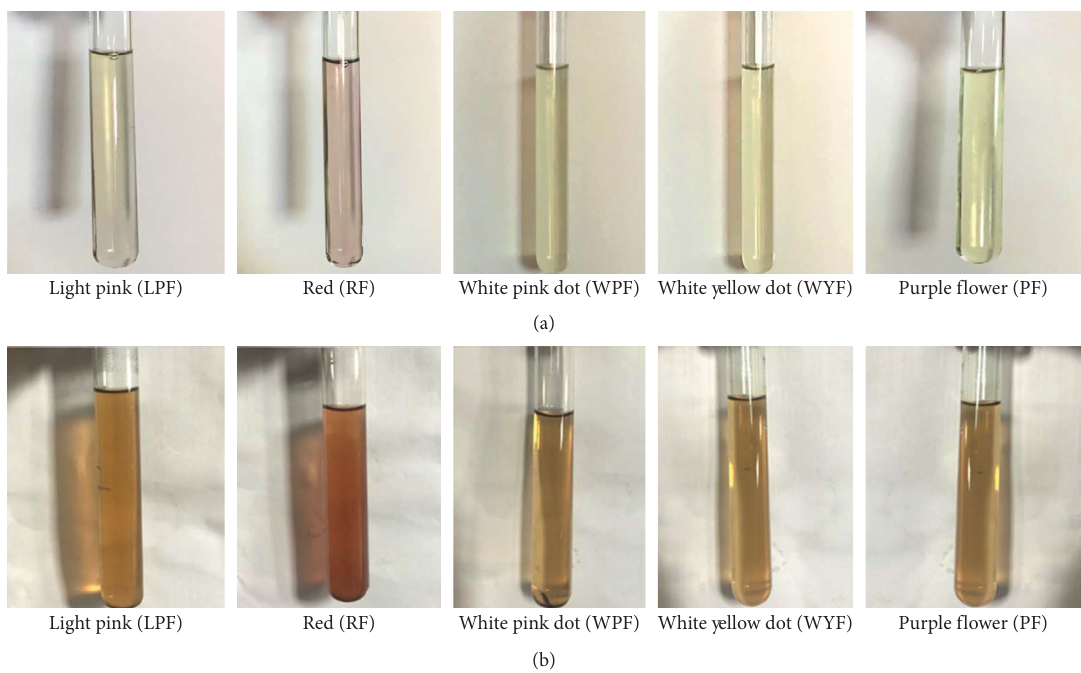
Figure 8: Green synthesis of AgNPs. (a) Flower extracts mixed with silver nitrate before 3 days and (b) after 3 days at RT.